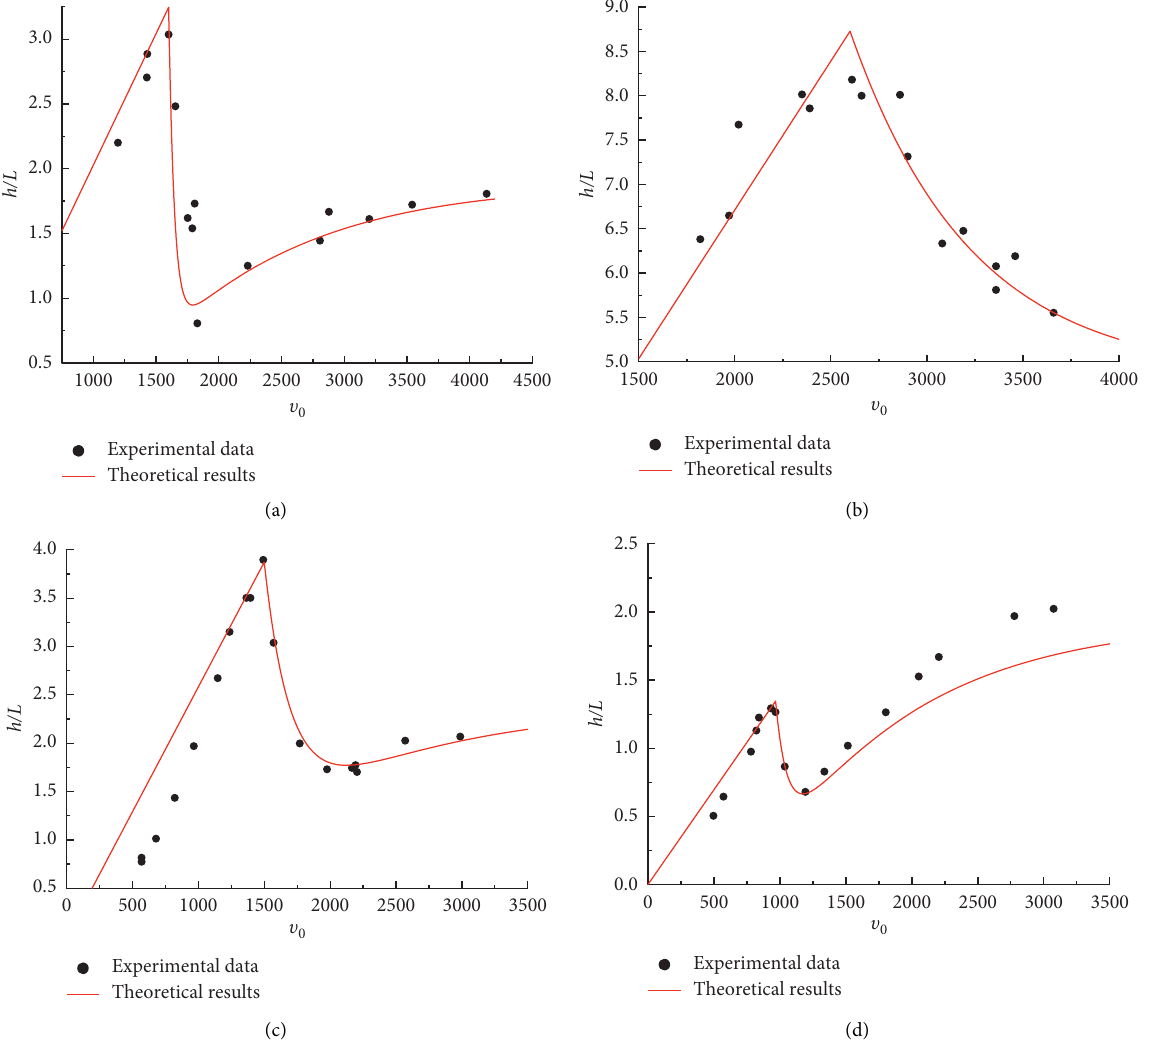
Figure 9: Theoretical and experimental DOPs of penetration experiments. (a) υ υ m � 1500m/s and α � 7. (d) υ m � 967m/s and α � 10.